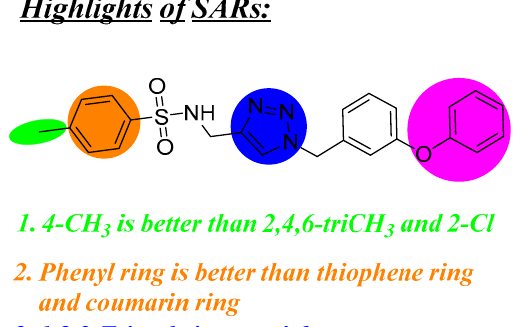
Figure 6. Summary of SARs .